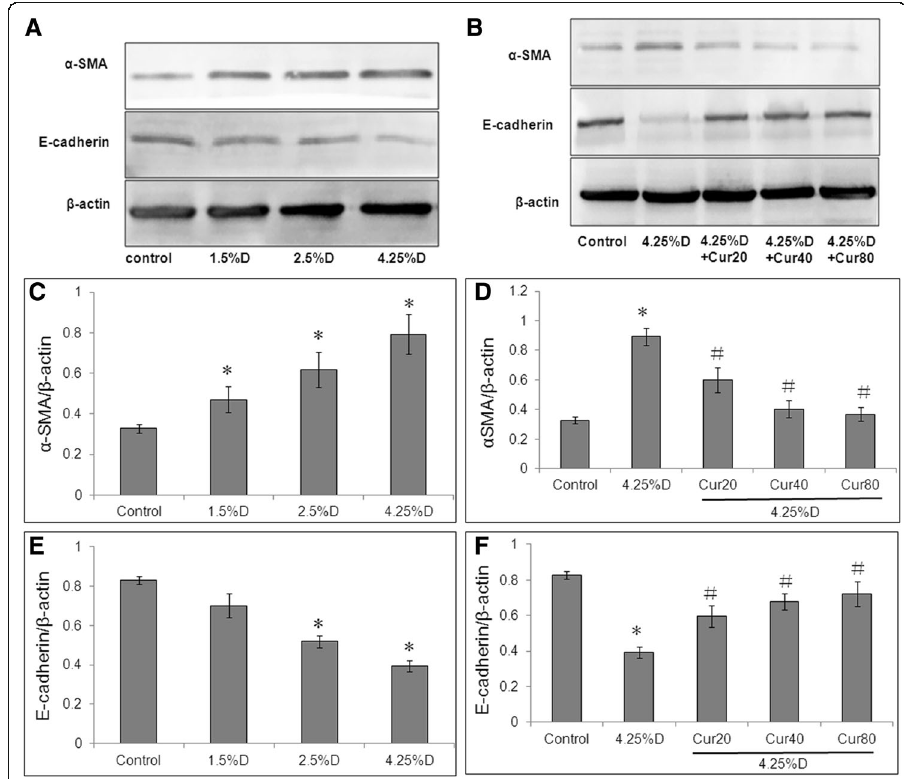
Fig. 3 Effect of curcumin on PD-induced EMT marker protein expressions in HMrSV5 cells. Cells were divided into control group (cells treated with DMEM/F12 medium containing 0.5%FBS), three PD groups (cells treated with 1.5% Dianeal, 2.5% Dianeal and 4.25% Dianeal) and three 4.25% Dianeal + curcumin group (cells treated with 4.25% Dianeal plus curcumin of 20, 40 and 80 μ M). After incubation for 48 h, cells were lysed using RIPA buffer for western blot assay. Representative immunoblots of α -SMA, E-cadherin and β -actin in HMrSV5 cells under various treatments are shown ( a , b ). β -actin served as a loading control. The density of protein bands were converted into grayscale values and are expressed as mean ± SEM. Relative protein expressions of α -SMA ( c , d ) and E-cadherin ( e , f ) are normalized to those of β -actin in HMrSV5 cells under various treatments. * P < 0.05 vs. control group; # P < 0.05 vs. 4.25% Dianeal